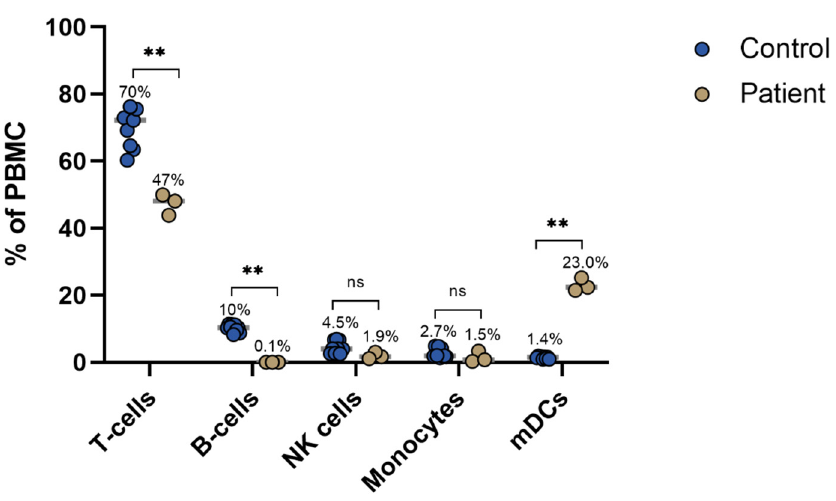
Figure 3. Frequencies of major immune subsets. Significance levels analysed by the Mann–Whitney test: ns = P > 0.1, ** = P ≤ 0.01. Gray lines indicate mean values. PBMC: peripheral blood mononuclear cells.